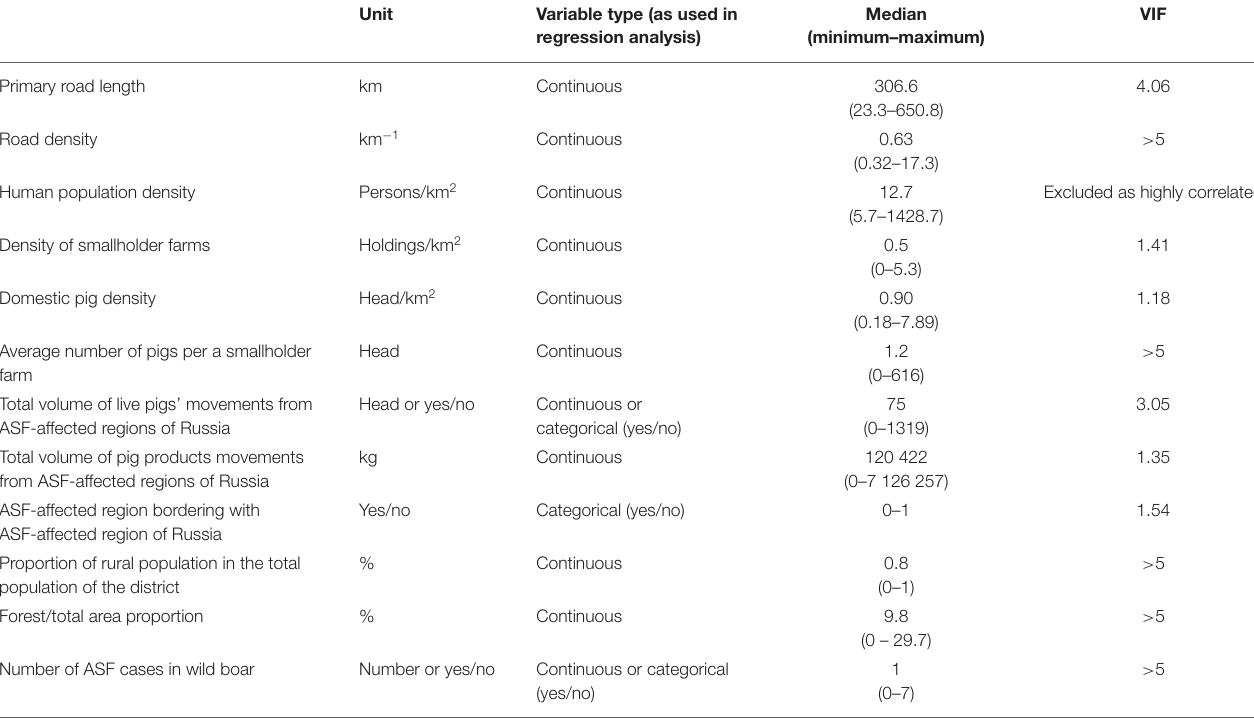
TABLE 1 | Geospatial